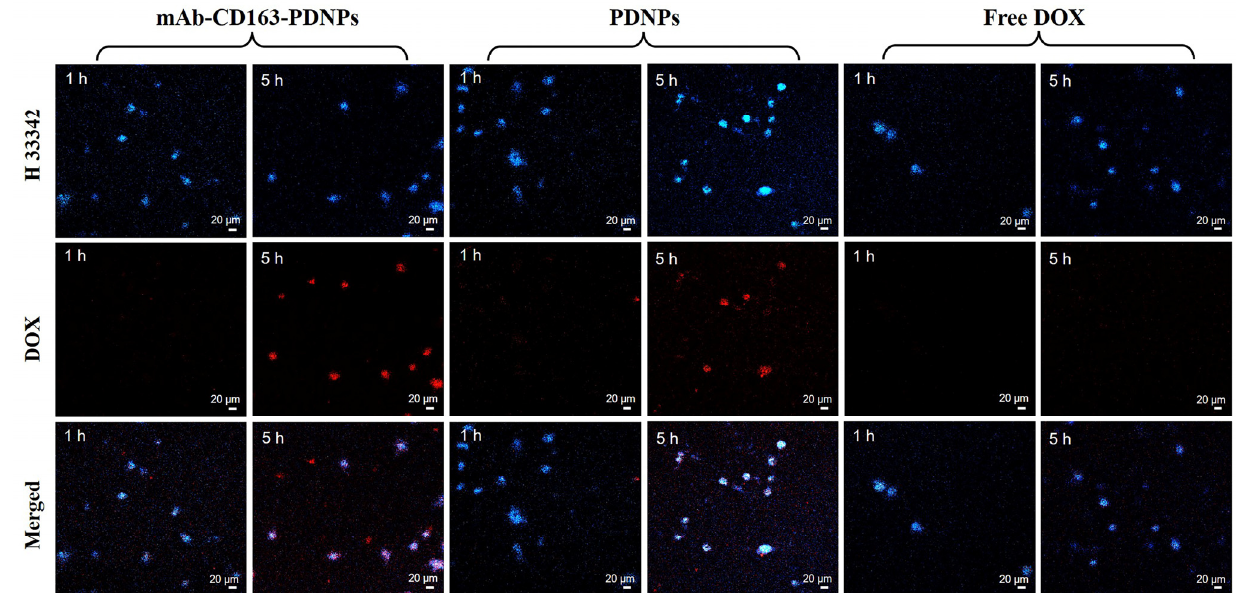
Figure 6. Intracellular fluorescence images of M2-type macrophages after treatment with mAb- CD163-PDNPs, PDNPs, and free DOX for 1 h and 5 h, respectively. The pictures in the first row show the nucleus stained with H 33342 fluorescent dye (blue). The second row is images of the red fluorescence of DOX entering M2-type macrophages. The third row is images of the combination of the above two fluorescence (scale bar = 20 μ m).